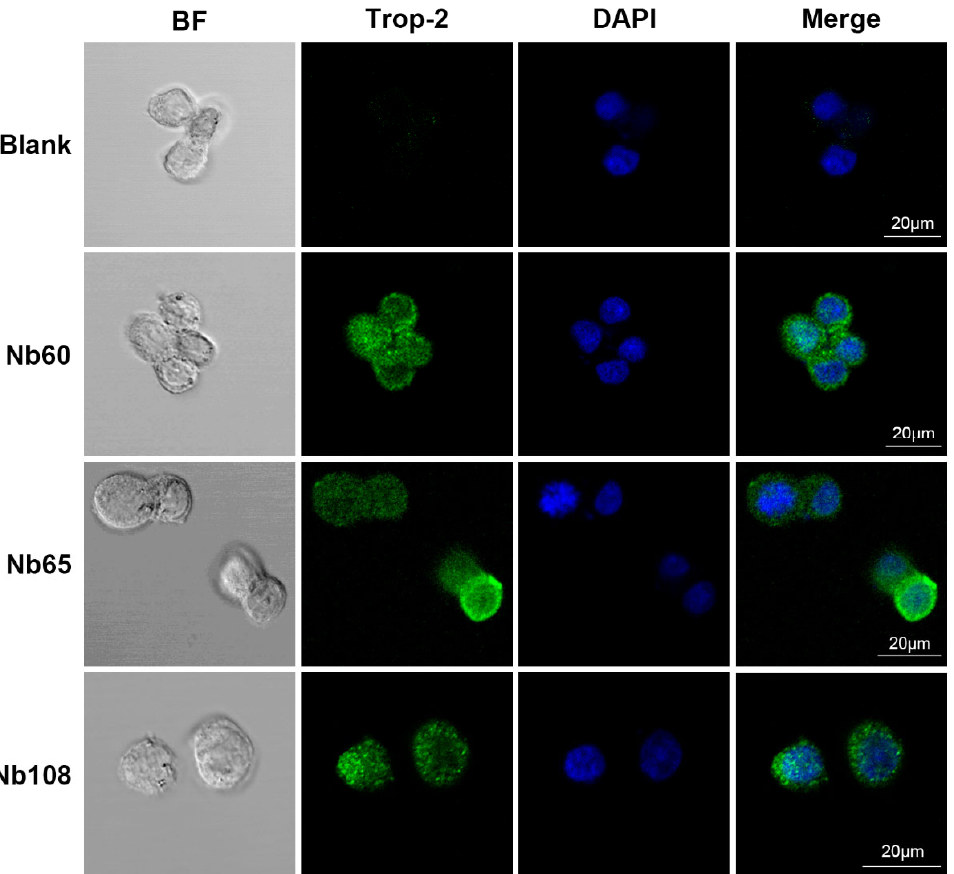
Figure 7. Cell staining of the selected Nbs in confocal immunofluorescence. The HCT116 cells were fixed with 4% paraformaldehyde and blocked with 1% BSA. Then, the Nbs were incubated with cells to allow targeting to the cell surface. Mouse anti-HA monoclonal antibody and Alexa Fluor ® 488-conjugated goat anti-mouse IgG were used to stain the displayed Nbs, and DAPI was applied to stain the nucleus.